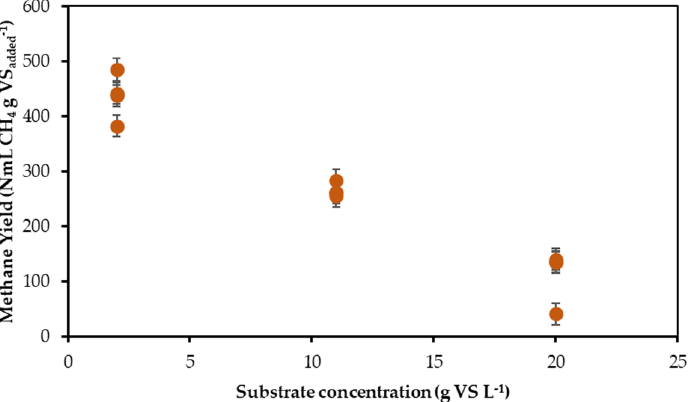
Figure 4. Influence of the olive alperujo concentration (g VS L − 1 ) on the methane yield (average value ±